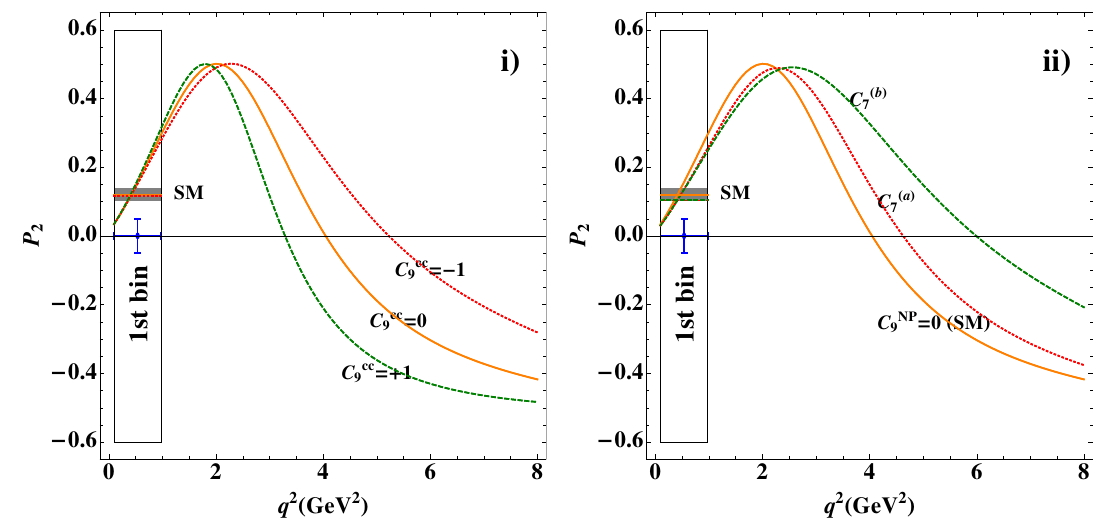
Figure 2 . i) Sensitivity of P 2 (central value only) to the variation of charm in C 9 taking C c (cid:22) c C c (cid:22) c = C c (cid:22) c = (cid:6) 1. ii) P 2 sensitivity to the variation of charm in C 7 : the solid orange line is the SM 9 ? 9 k central value, the dotted red line (a) corresponds to the central value for C c (cid:22) c (cid:0) 0 : 093, C NP = 0, the green dashed line (b) corresponds to the central value for C c (cid:22) c 9 C c (cid:22) c = (cid:0) 0 : 083, C NP = (cid:0) 1 : 1. The blue cross indicates the LHCb measurement of the (cid:12)rst bin [4] 9 7 k (strictly speaking for ^ P 2 ). The grey band corresponds to the SM prediction, whereas the coloured lines correspond to the central value of the binned prediction for each